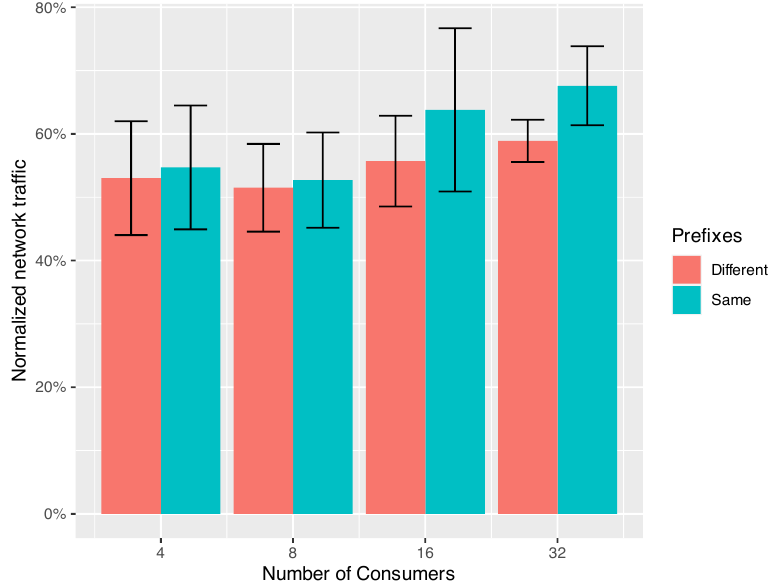
Figure 6. Total amount of data exchanged (normalized) through the network when a set of consumers requests content from a producer at their maximum attainable rate. As before, as the number of consumers increases, the amount of total data transmitted also augments. Even with the link from the producer saturated, the consumers can still get high throughput because their data copies do not have to travel from the producer itself. With no caches, this sharing is only due to the coalescing of interest packets. However, with active caching, the sharing also comes from copies of data previously forwarded by individual satellite